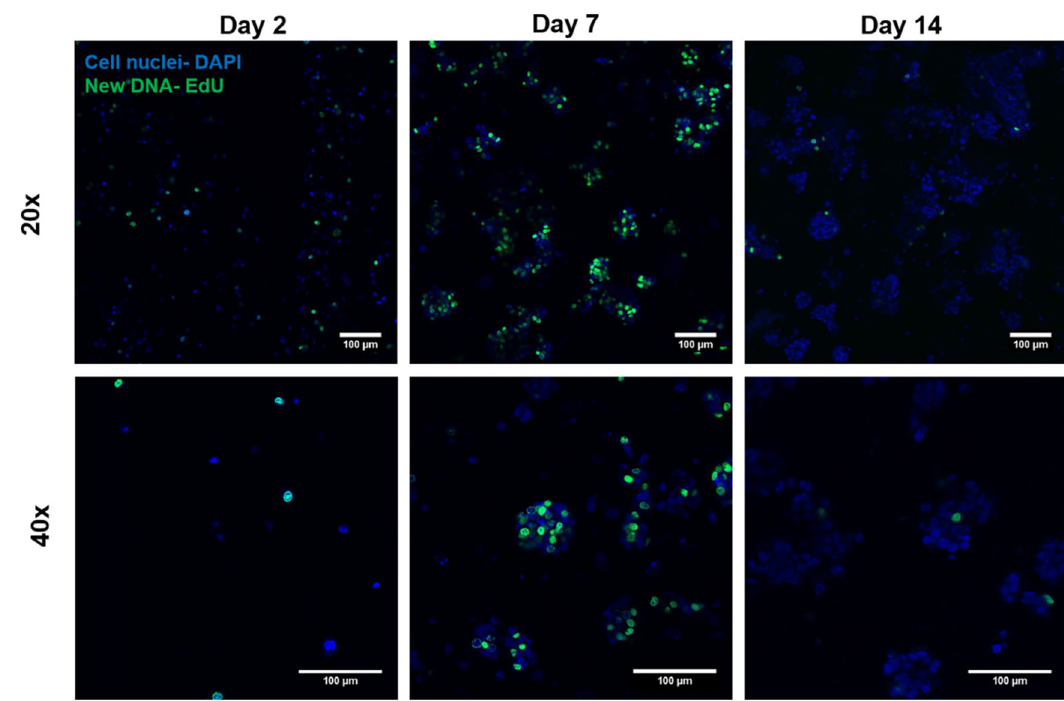
Figure 3. Proliferation of HepG2 embedded in algMC with Matrigel – EdU proliferation assay. Cell nuclei were stained with DAPI (blue); representing original cells, while cells labelled with EdU are shown in green; representing newly formed DNA and therefore mitosis. Upper tile (20 × magnification) shows the distribution of newly formed cells allover a specific region of the scaffold. Lower tile (40 × magnification) shows distribution of cells within the formed clusters and their rate of proliferation; scale bars represent 100 µm.